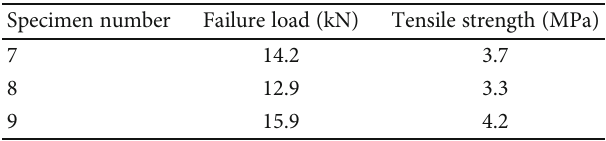
Table 5: Results of Brazilian splitting